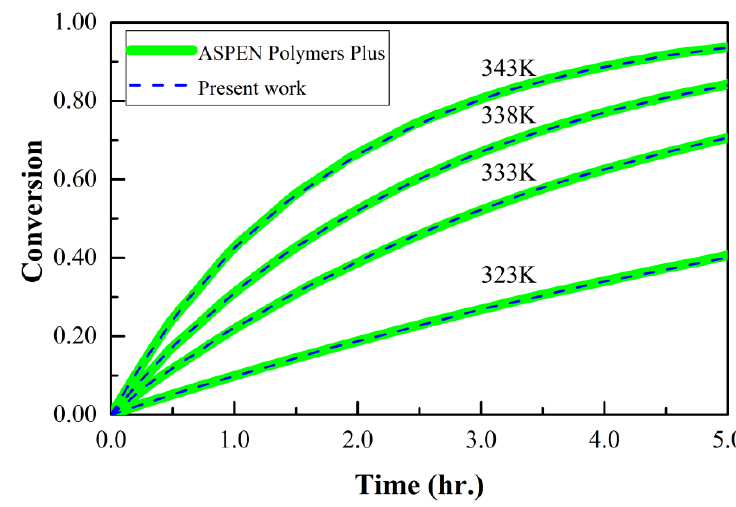
Figure 6. ‘Benchmarking’ of simulation data by comparison with ASPEN modeling: conversion versus time data for MMA polymerization with NOS-1 initiation policy.